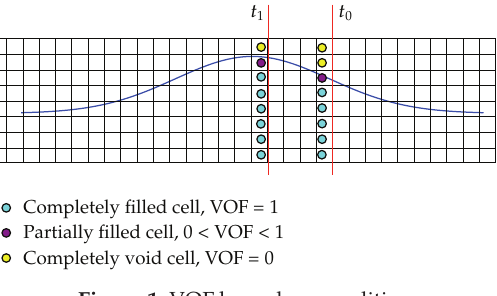
Figure 1: VOF boundary